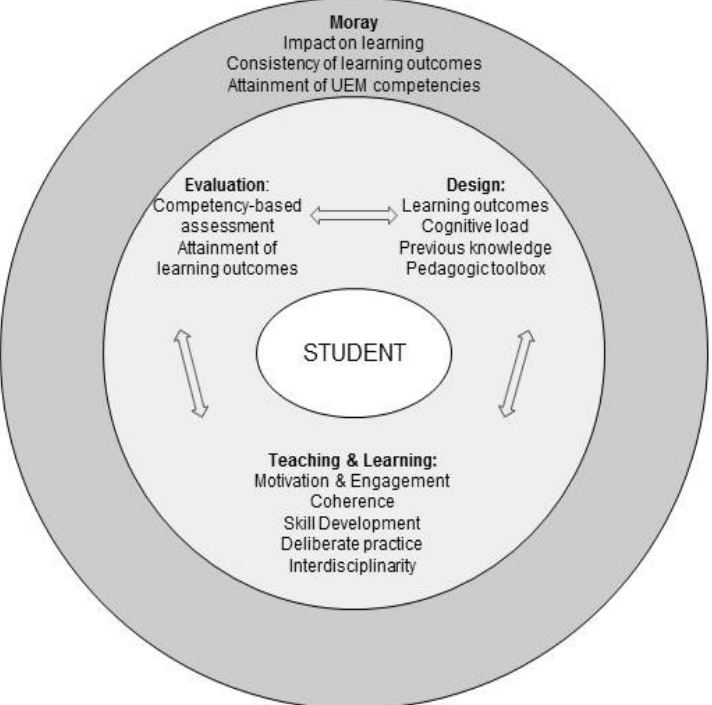
Fig. 4. Structural model for the design of faculty workshops. The semester-long course for selected faculty members follows the same structure as they should follow when de- signing a new course under UEM guidelines. Since the student lies at the center of the process, the initial design is shaped by the desired learning outcomes, his/ her precon- ceptions, prior knowledge, and cognitive capacities. The teaching and learning process has to motivate and engage the student in such a way that skills are developed through experimentation and active learning. Finally, the evaluation phase tests whether the de- sired skills have been developed and the learning outcomes attained. Moray has the overarching task of ensuring coherence and consistency for the development of UEM